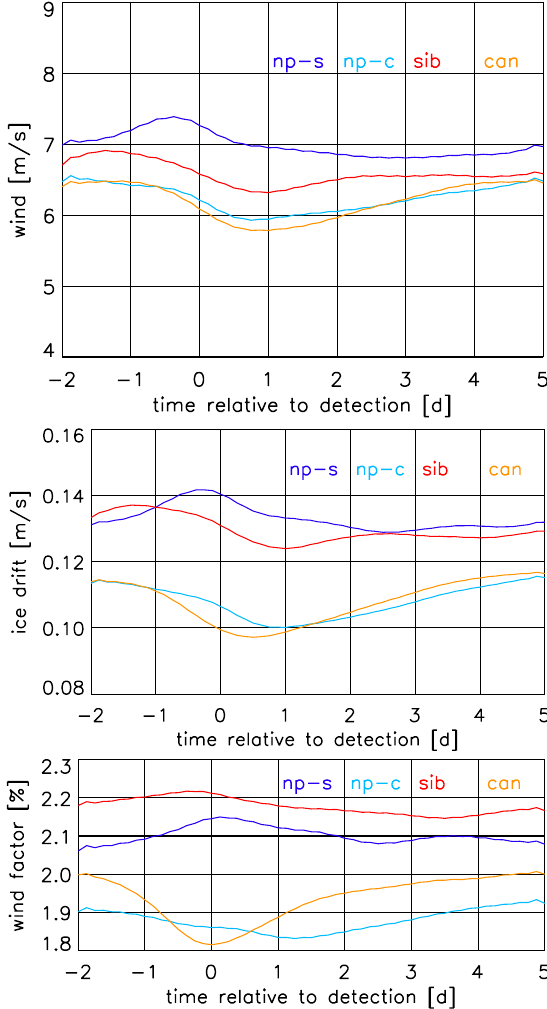
Fig. 14. As in Fig. 5, but for different sub-regions of the Arctic Ocean.